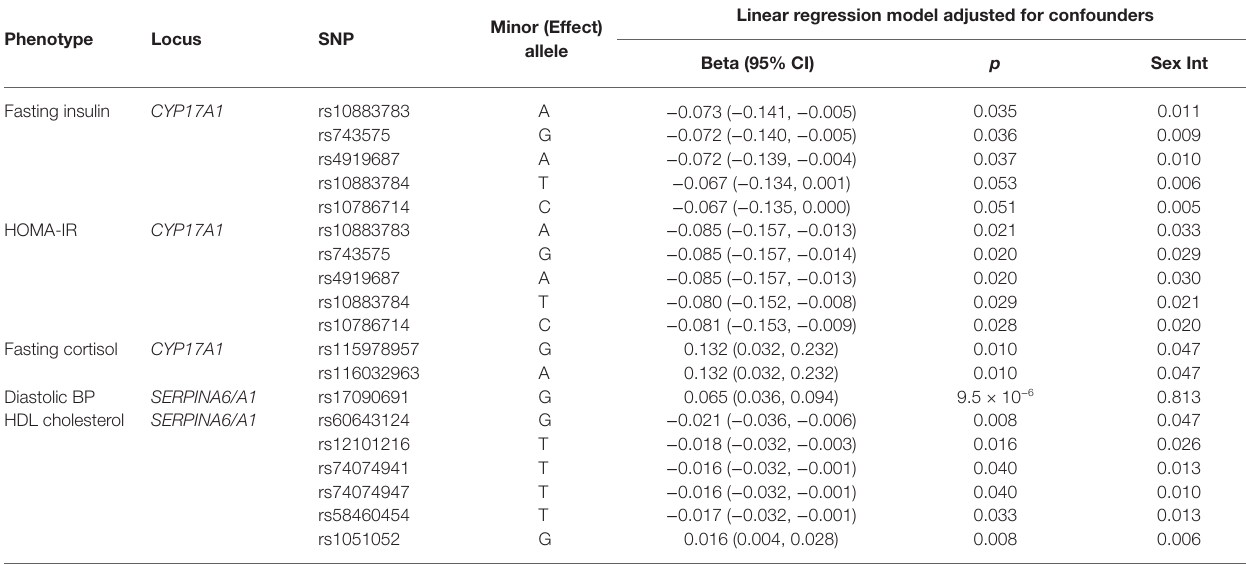
Linear regression model adjusted for confounders Minor (Effect) allele Beta (95% CI) Sex Int